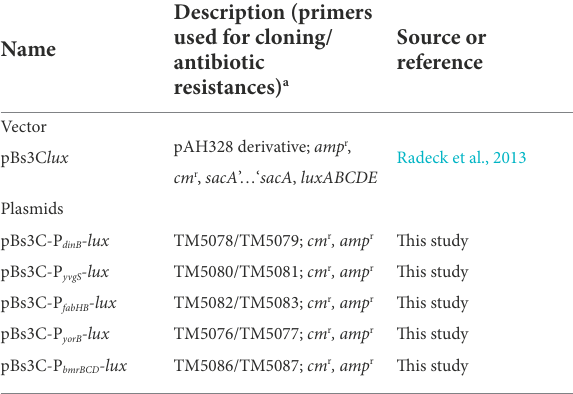
TABLE 4 Vector and plasmids used in this